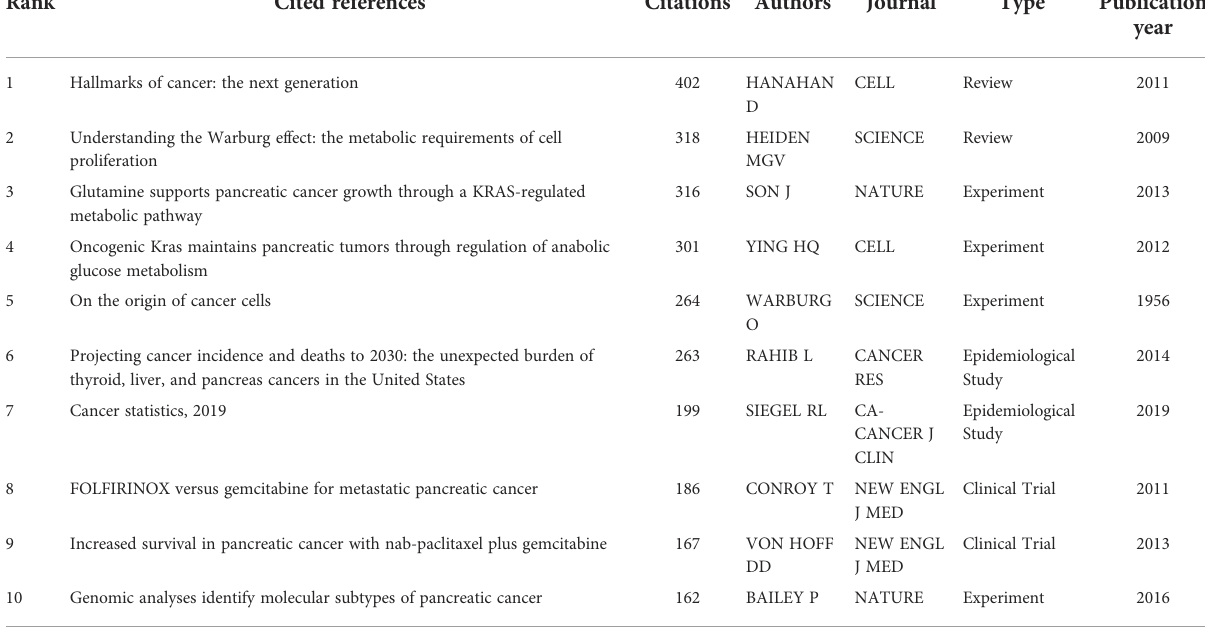
TABLE 5 The 10 most cited articles in the fi eld of pancreatic cancer metabolism.